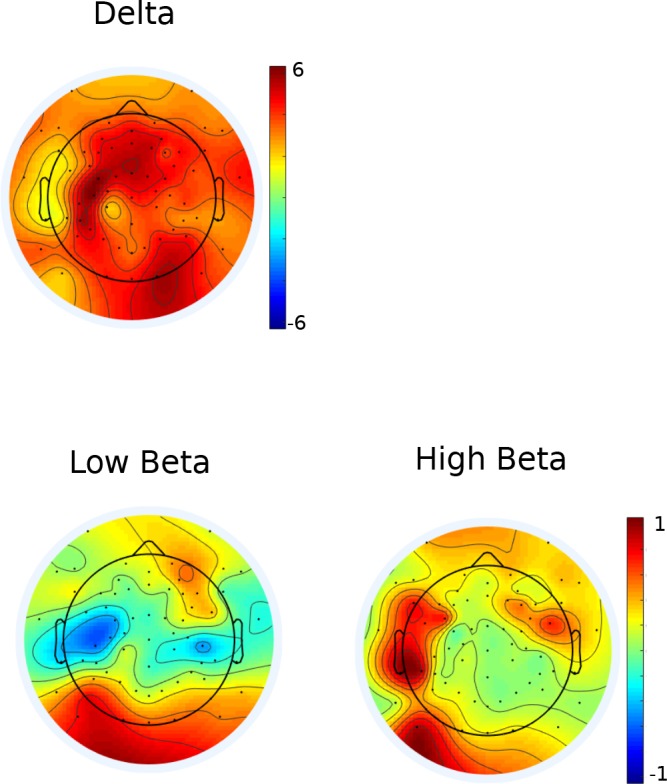
Non-significant frequency band topographies.This figure shows the remaining frequency bands not shown in Figure 4. Variations in the power of Delta, Low Beta and High Beta were not significant predictors of MEP amplitude. The blue-red range of the plots is shown to the right of each figure.